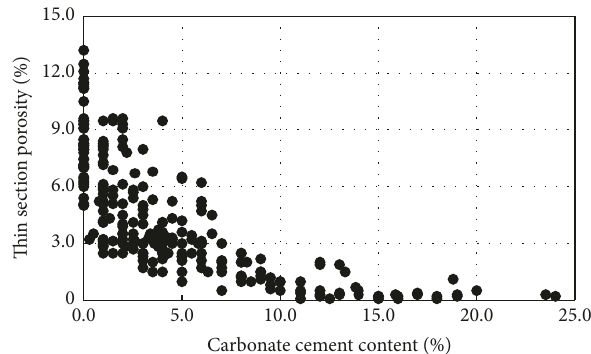
Figure 5: Scatter diagram showing the relationship of thin section porosity versus carbonate cement content.